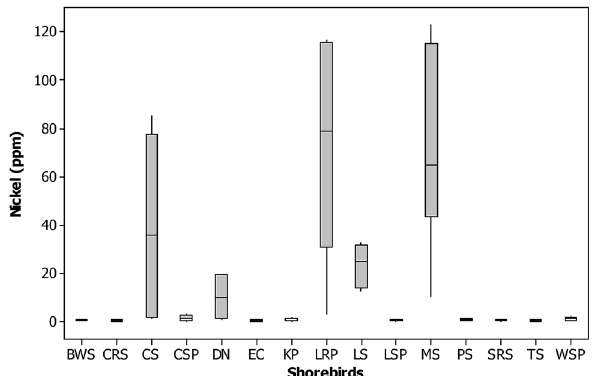
Figure 7. Box plot showing the concentration of Nickel (ppm) recorded in different shorebird species at Point Calimere Wildlie Sanctuary, Kodikkarai and Pichavaram Mangrove Forest, Pichavaram, east coast of Tamil Nadu, India.